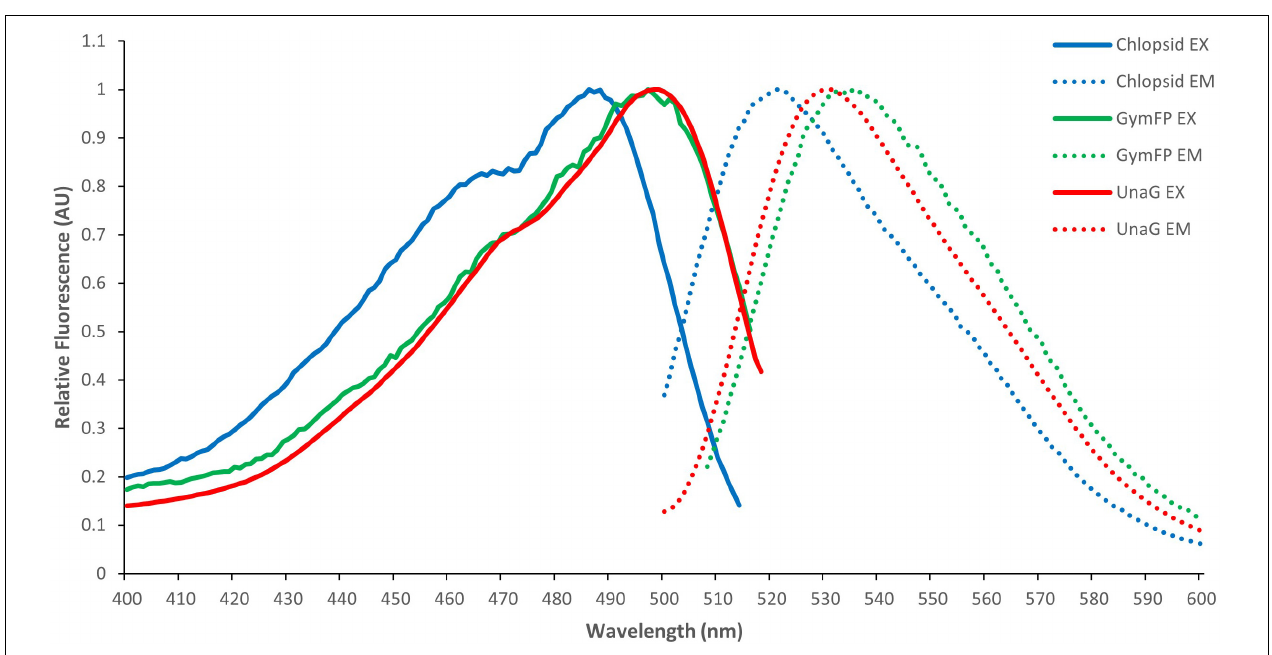
FIGURE 3 | Excitation (EX) and emission spectra (EM) of GymFP with bilirubin (1:1 complex, 2.1 µ M). GymFP was held in 50 mM Tris HCl, 150 mM NaCl, 300 mM Imidazole, pH 7.4. Bilirubin was held in 1X PBS (1.19 mM phosphates, 13.7 mM sodium chloride, 270 µ M potassium chloride), pH 7.3.